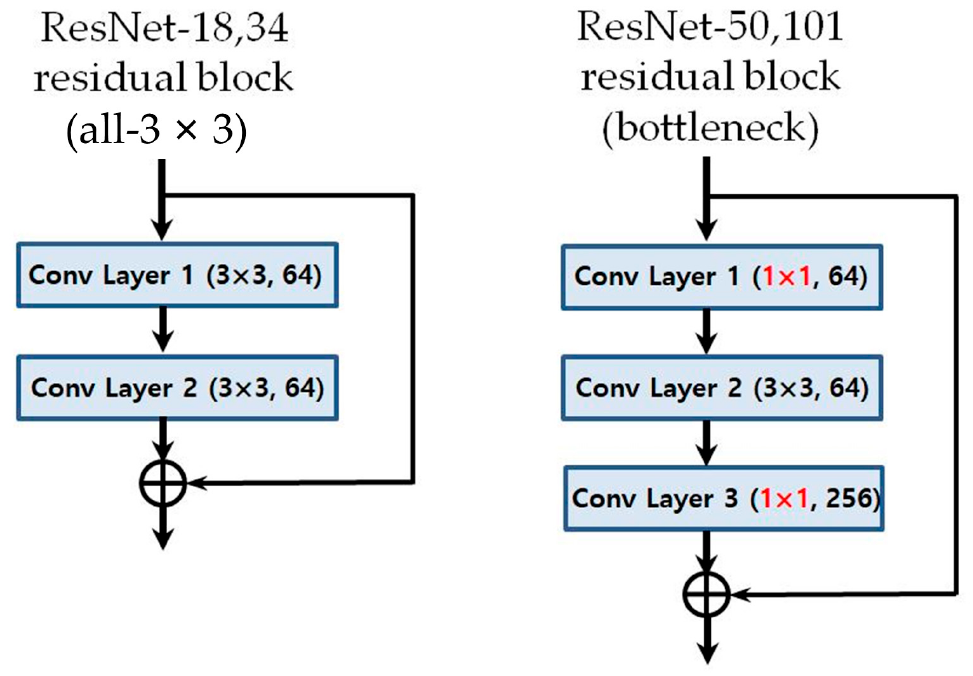
Figure 7. Comparison between models’ residual block structures: 3 × 3 structure for ResNet-18 and 34 and bottleneck structure for ResNet-50 and